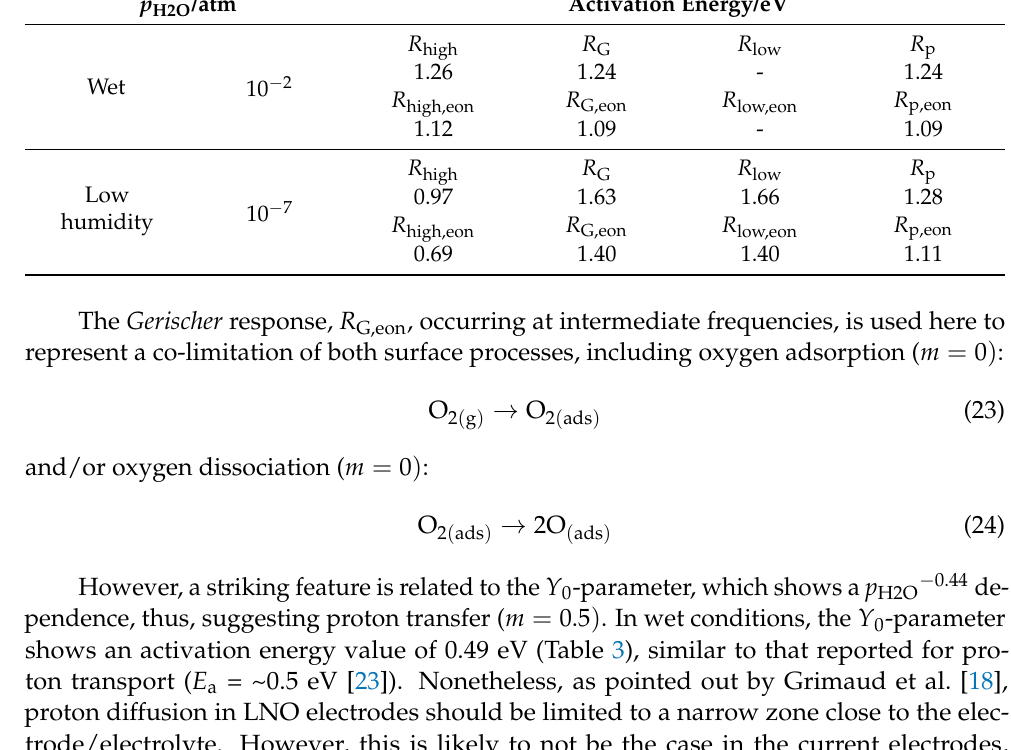
Table 3. Calculated values for the activation energy obtained in both wet and low humidity conditions. p H2O /atm Activation Energy/eV